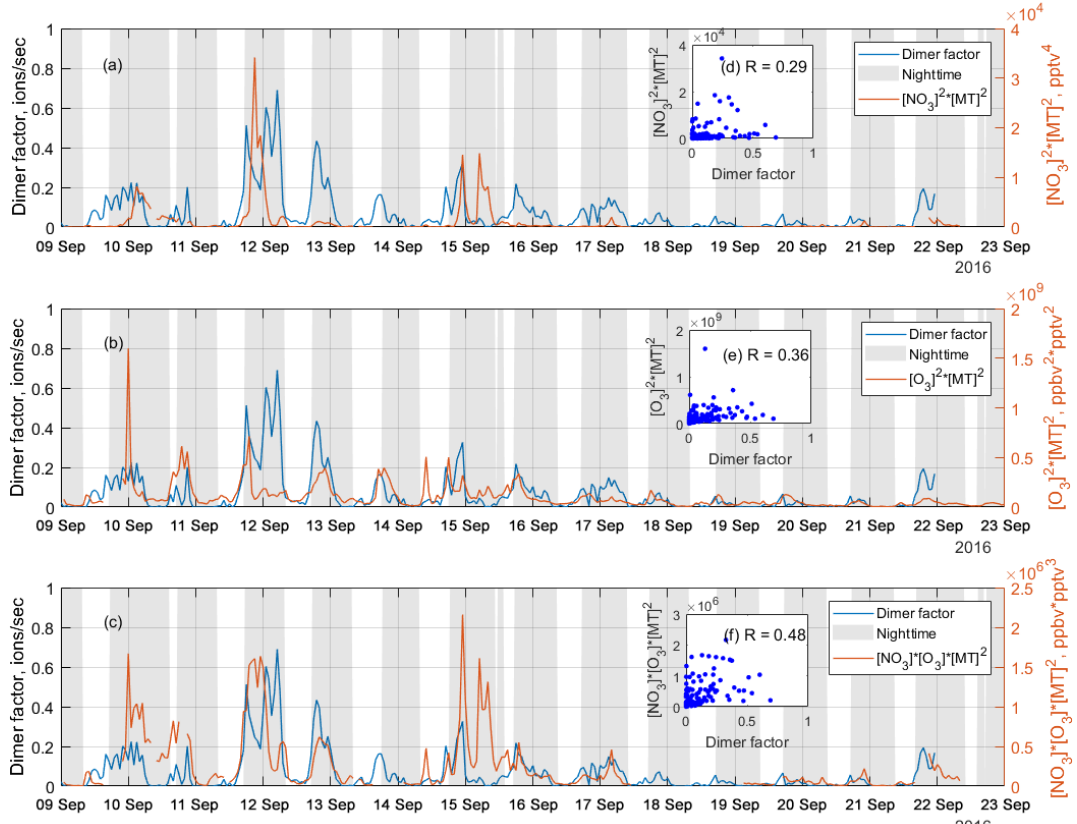
Figure 7. Time series of the NO 3 oxidation dimer factor (blue line) and the products of (a) [NO 3 ] 2 × [monoterpene] 2 , (b) [O 3 ] 2 × [monoterpene] 2 , and (c) [NO 3 ] × [O 3 ] × [monoterpene] 2 , where [] represents concentration in units of pptv for NO 3 radicals and monoter- pene and ppbv for O 3 , while the scatter plots are shown as inserts, (d) , (e) , and (f) , respectively. The scatter plots and correlation coefficients, R , are only calculated from nighttime data, which is selected based on solar radiation, to eliminate the influence from daytime oxidation